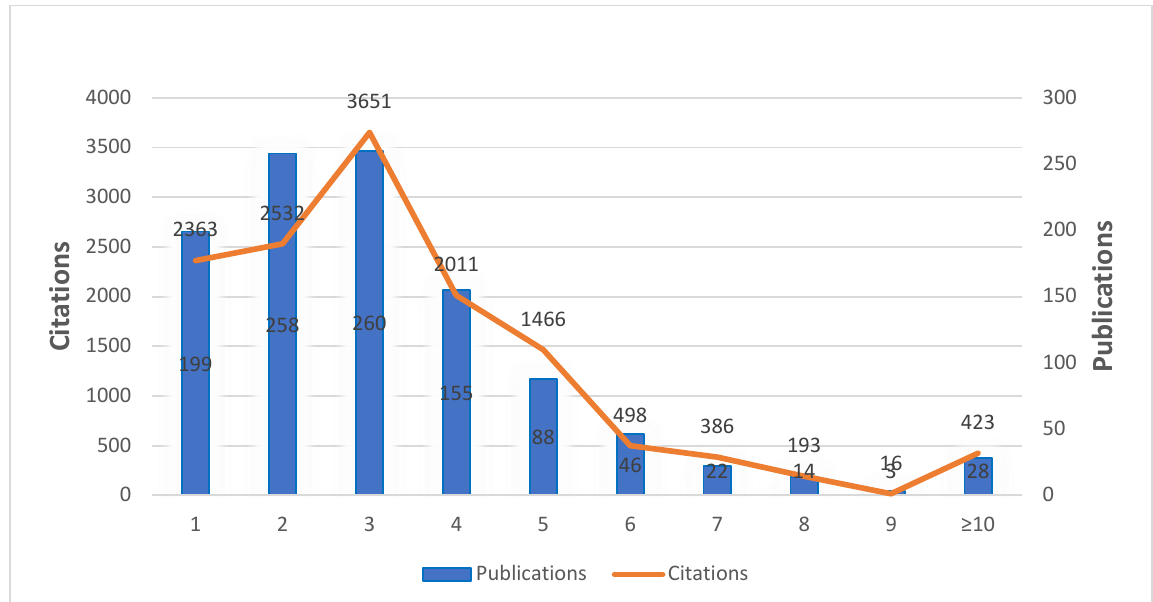
Figure 3. Authorship pattern of the VR researchers.